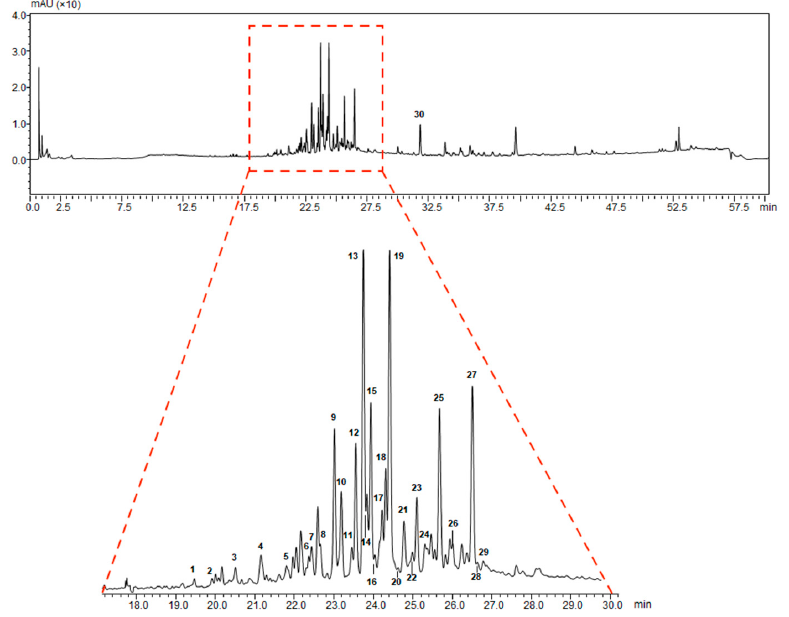
Figure 1. UHPLC-PDA ( λ = 254 nm) chromatographic profile of the G. lucidum extract.